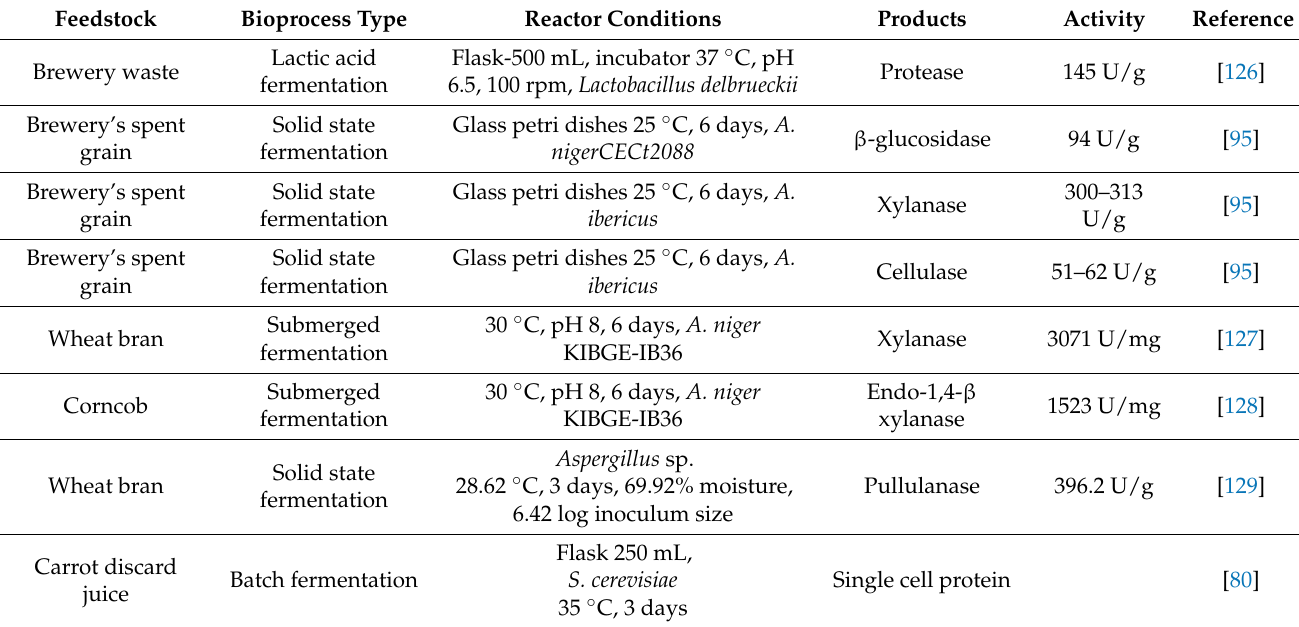
Table 4. Enzymes and proteins from food waste